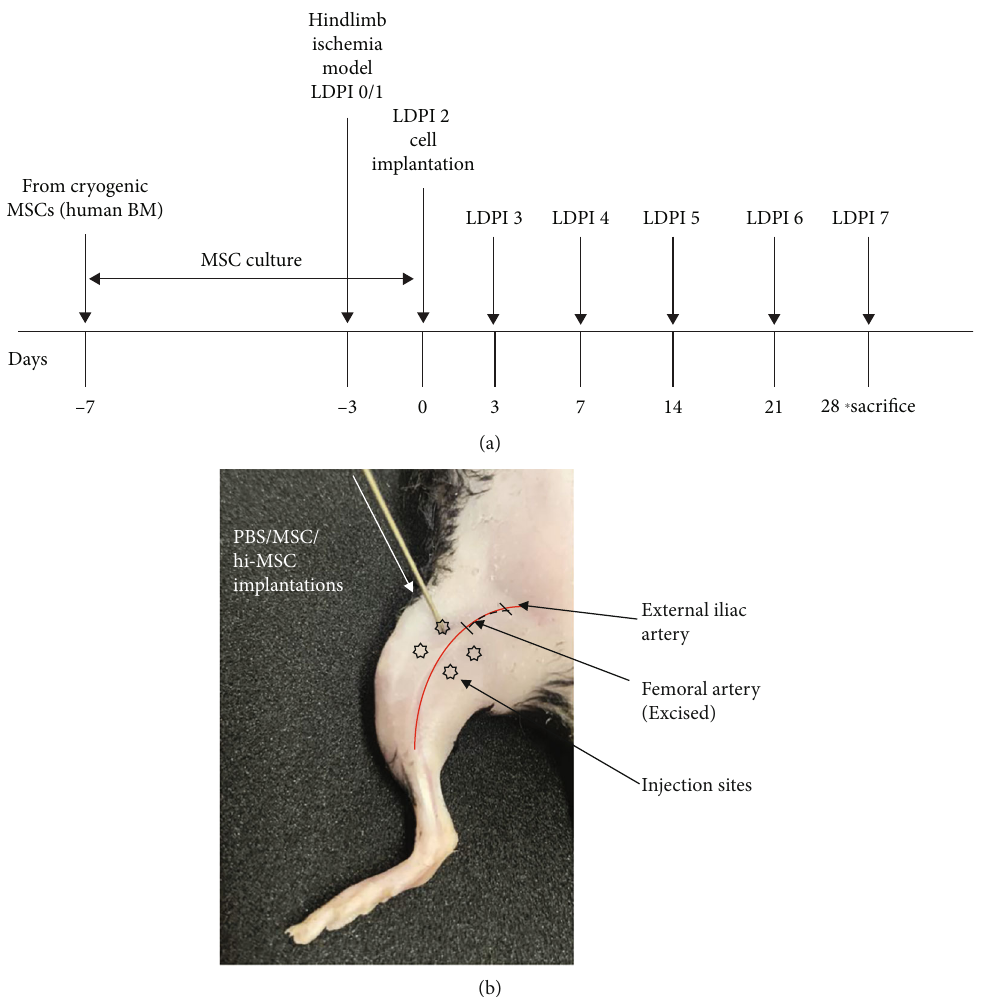
Figure 1: Schedule of the study and hindlimb ischemic model. (a) Protocol schedule for the in vivo disease model, mesenchymal stem cell (MSC) implantations, follow-up, and acquisition of samples. (b) Hindlimb ischemic model and phosphate-bu ff ered saline (PBS)/MSC/ hypoxia-induced MSC (hi-MSC) injection sites